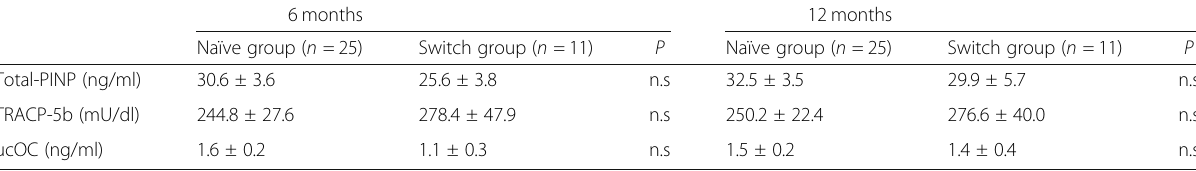
Table 5 The bone turnover markers levels at 6 and 12 months in the naïve and switch